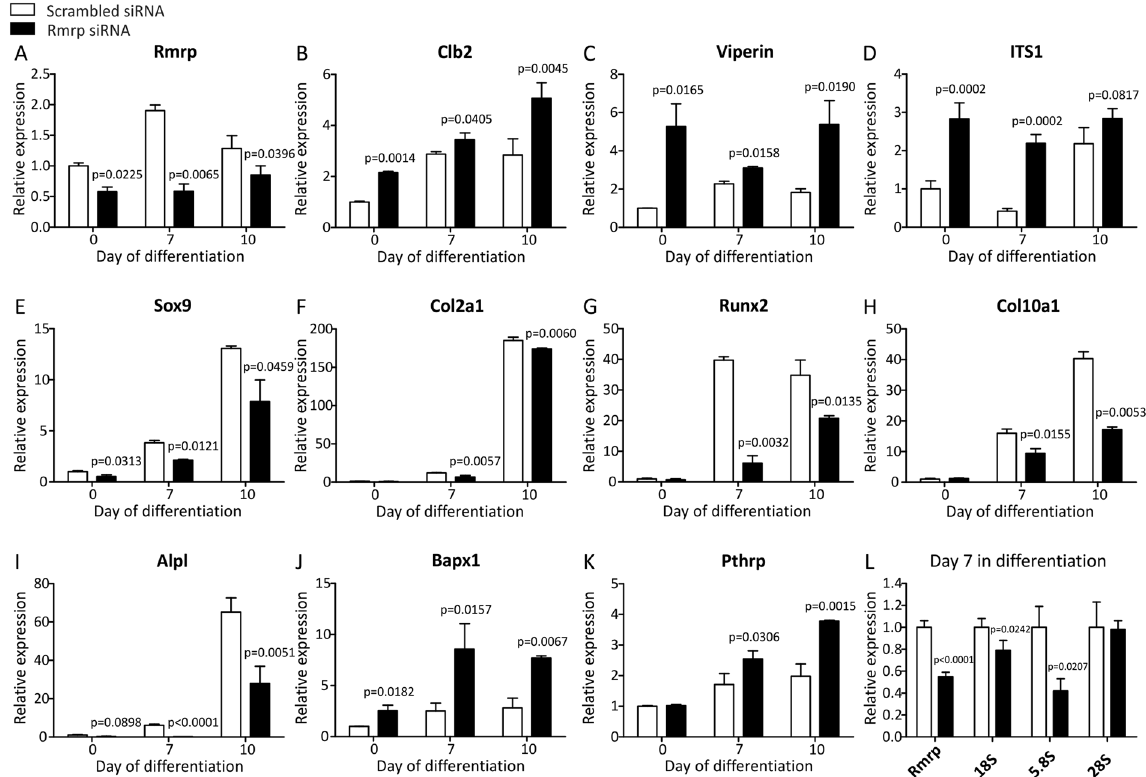
Figure 6. Rmrp RNA knockdown deregulates ATDC5 chondrogenic differentiation. ATDC5 cells were transfected with 100 nM siRNA duplex targeting Rmrp RNA expression on day -1, day 2, and day 5 during chondrogenic differentiation. A scrambled siRNA was used as control condition. RNA was isolated from these cultures at day 7 and 10 in differentiation and at t = 0 as a reference. Expression of Rmrp ( A ), Clb2 ( B ), Viperin ( C ), ITS1 rRNA processing intermediate ( D ), Sox9 ( E ), Col2a1 ( F ), Runx2 ( G ), Col10a1 ( H ), Alpl ( I ), Bapx1 ( J ), PthrP ( K ) and Rmrp , 18S, 5.8S and 28S ( L ) was determined by means of RT-qPCR. Gene expression is depicted as fold induction relative to t = 0 ( A–K ). In Fig. 6L day 7 scrambled controls are set to 1. Data was normalized to β -actin and represents the average value of 3 (Fig. 6A–K) or 4 (Fig. 6L) biological replicates plus standard deviation. For statistical evaluation an independent samples t-test was performed relative to scrambled control for each consecutive time point using GraphPad Prism 5. p-values are indicated. Presented graphs are representative examples of three independent